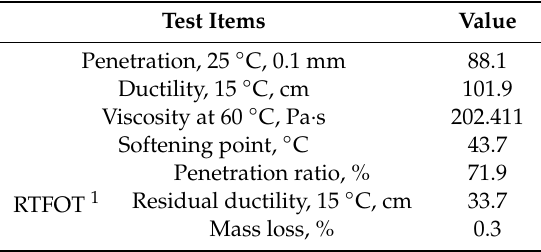
Table 1. Technical indicators of A-90 bitumen.